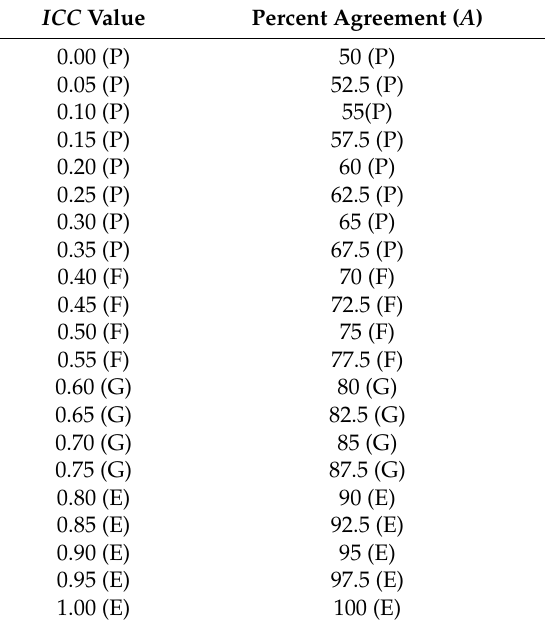
Table 2. The Correspondence between ICC and Percent Agreement [18] 1